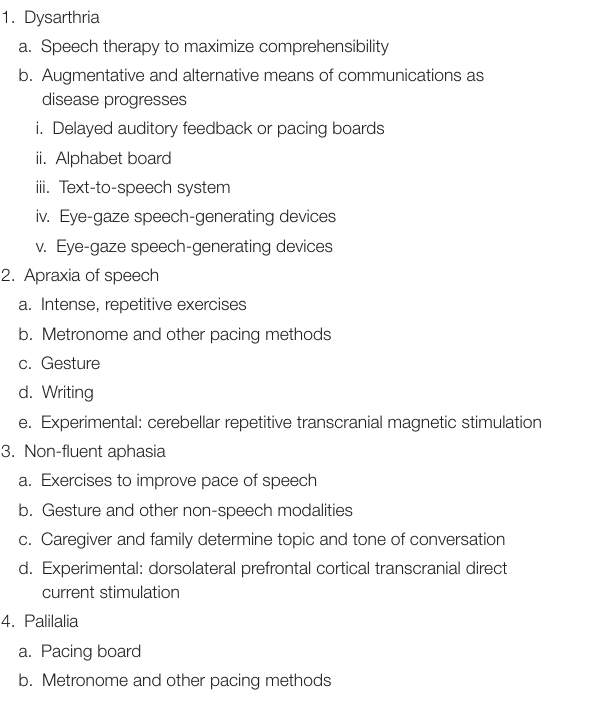
TABLE 9 | Management of speech impairment in